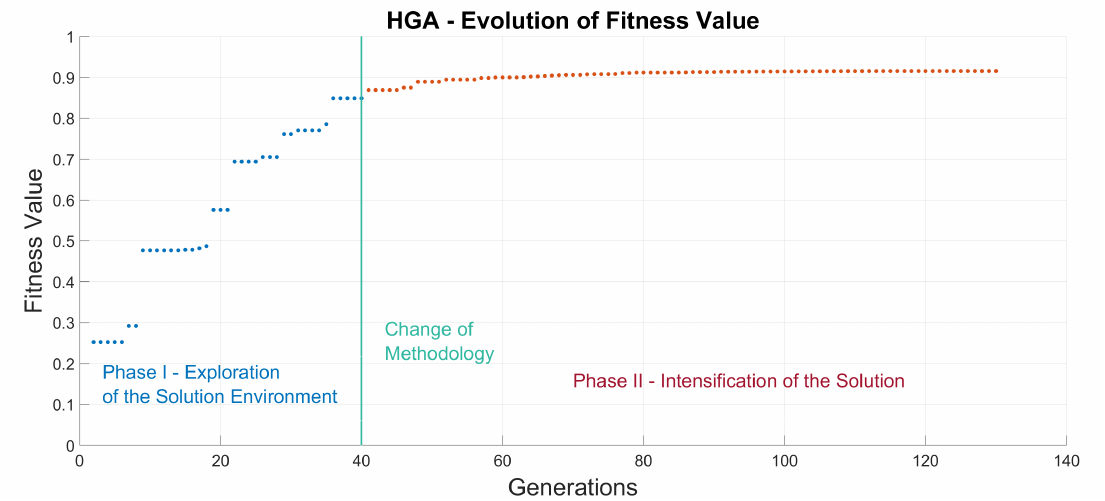
Figure 4. Hybrid Genetic Algorithm (HGA) optimization for the node location problem.